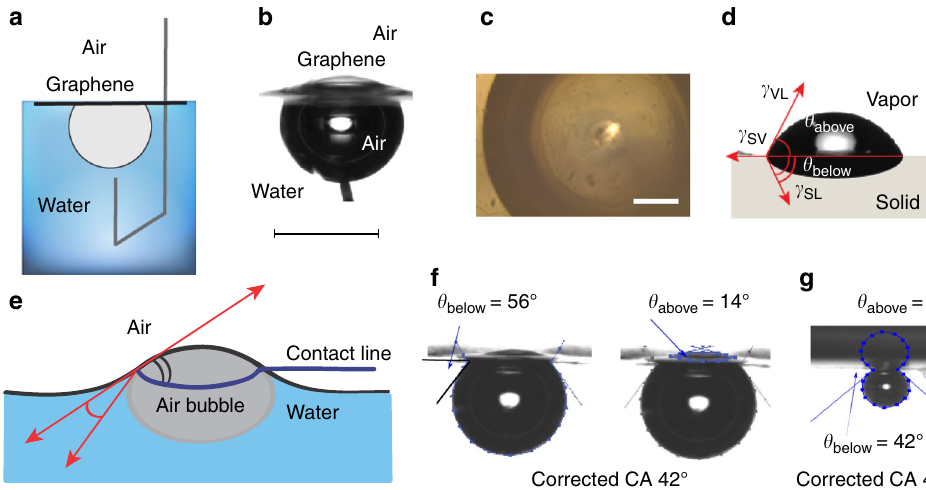
Fig. 2 Captive bubble con fi guration for measuring the contact angle of water on free-standing graphene. a Schematic illustration of the captive bubble setup for measuring the contact angle of water on free-standing graphene. b Optical image of graphene on top of an air bubble (side view). Scale bar represents 2 mm. c Optical image of graphene suspended above the air bubble (top view). Scale bar represents 500 µ m. d Geometry of the contact line on a soft elastic substrate. The contact angle of three phases is a sum of angles below ( θ below ) and above ( θ above ) the horizontal line. e Neumann ’ s triangle. Surface-energy balance for captive bubble on graphene. f Optical images of a captive bubble on graphene and calculation of the contact angle for an in fl ected graphene with an air bubble of 6 µ l. g Optical image of a captive bubble on graphene and calculation of the contact angle (bubble volume 0.2 µ